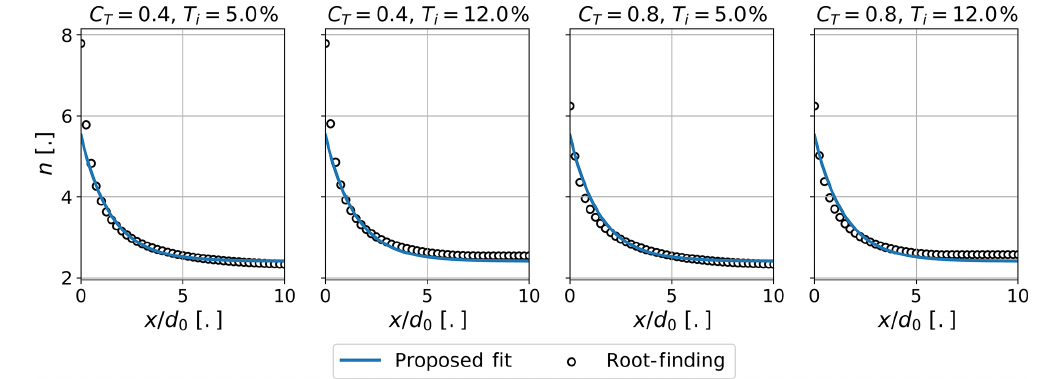
Figure 2. Comparison of the proposed fit for the super-Gaussian order with the root-finding approach for two thrust coefficients and two turbulence intensities.